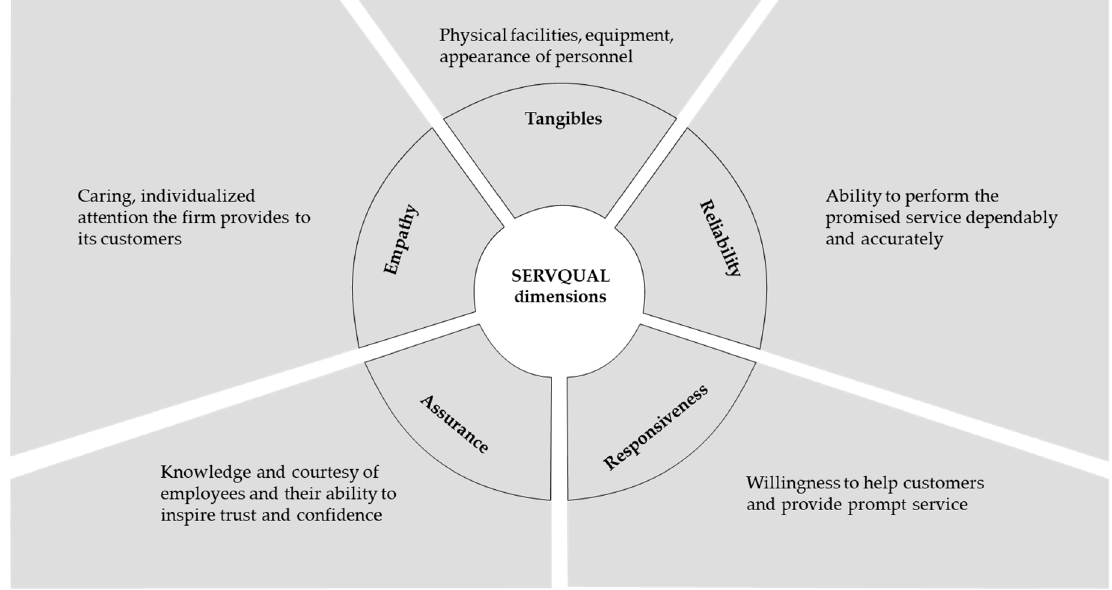
Figure 2. The five dimensions of SERVQUAL (Parasuraman et al. 1988).